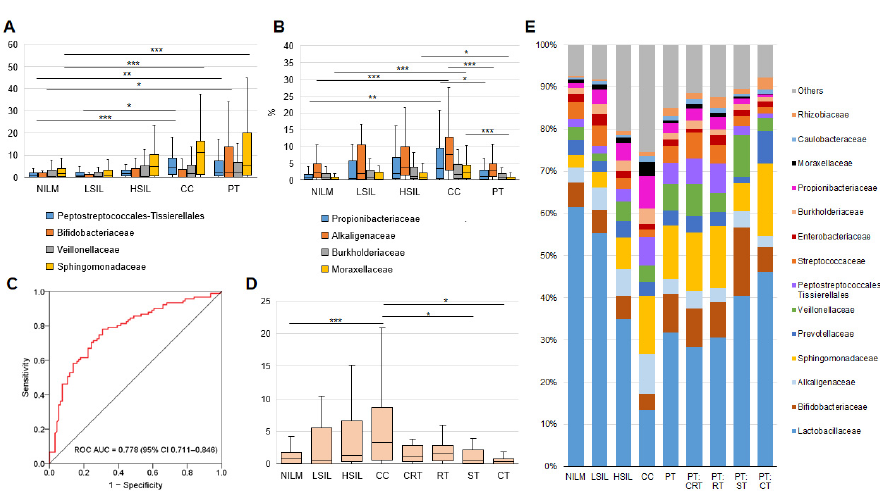
Figure 5. Non-LB species analysis by 16S rRNA gene sequencing. ( A ) Relative abundance counts of Peptococcales-Tissierellales, Bifidobacteriaceae, Veillonellaceae, and Sphingomonadaceae at different diagnoses and post-treatment. ( B ) Relative abundance counts of Propionibacteriaceae, Alcaligenaceae, Burkholderiaceae, and Moraxellaceae at different diagnoses and post-treatment. ( C ) The receiver-operating characteristic curve derived from training sample analysis for the detection of ≥ HSIL based on non-LB reads’ % count. The diagonal line indicates an area under the curve of 0.5. ( D ) Relative abundance counts of Cutibacterium acnes at different diagnoses and post-treatment. Differences between groups were assessed by the Mann–Whitney U test with the Bonferroni cor- rection for multiple testing; an adjusted p -value was calculated as a pairwise nonadjusted p -value multiplied by the total number of comparisons. The figure presents the median value, upper and lower quartiles, and a nonoutlier range; outliers are not shown. *** p ≤ 0.001; ** 0.001 < p <